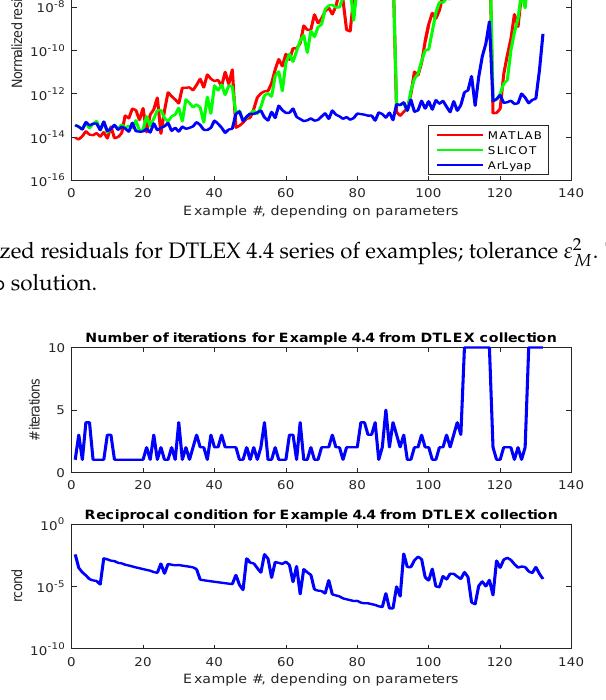
Figure 16. Number of iterations for ArLyap solver, initialized by dlyap solution, and reciprocal condition numbers for DTLEX 4.4 series of examples; tolerance ε 2